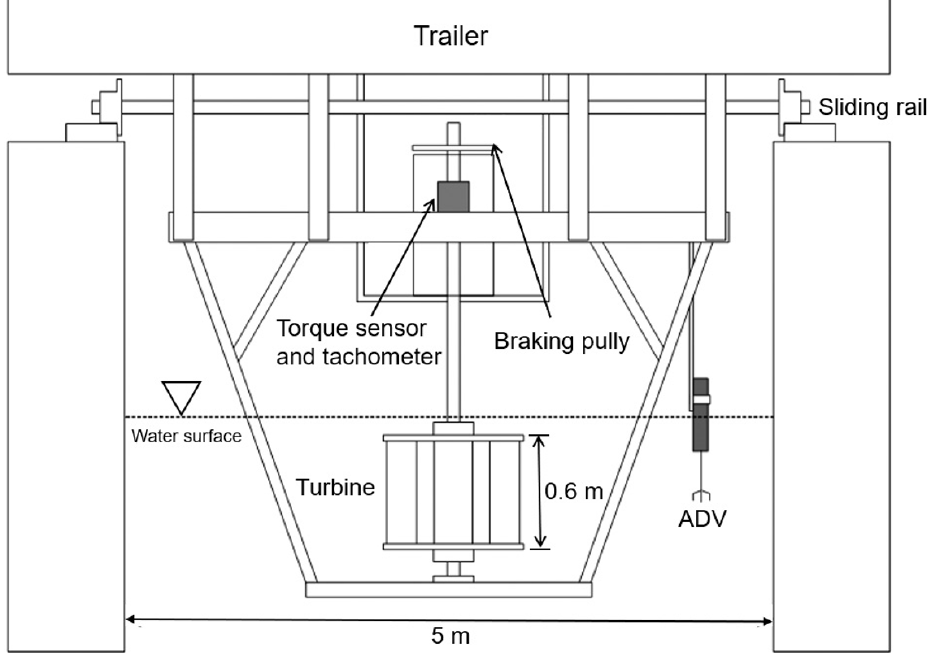
Figure 5. Schematic diagram of the towing